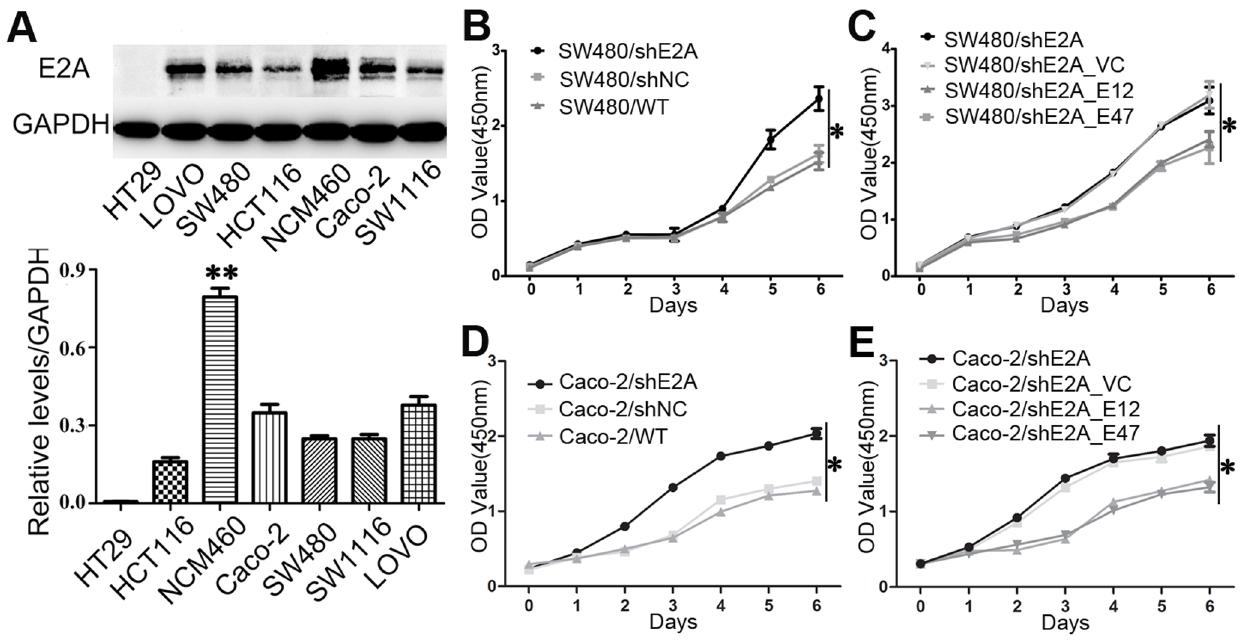
Figure 3. Knockdown of E2A promotes colon cancer cell growth. (A) Expression of E2A in normal human colon mucosal epithelium cell NCM460 and CRC cells lines was shown by western blot. GAPDH was used as loading control; (B) and (D) Cells with downregulated E2A expression (SW480/shE2A, Caco-2/shE2A) showed higher cell proliferation rate than that of the negative control (SW480/shNC, Caco-2/shNC) and wild type (SW480/WT, Caco-2/WT) cells; (C) and (E) Parental cells (SW480/shE2A, Caco-2/shE2A) were co-transfected with E12 or E47 plasmid (SW480/shE2A_E12 and SW480/shE2A_E47; Caco-2/shE2A_E12 and Caco-2/shE2A_E47) to restore E2A expression. Co-transfected cells showed decreased cell proliferation rate than that of the parental or vector control (SW480/shE2A_VC, Caco-2/shE2A_VC) transfected cells. All data represented as mean value 6 SD from 3 independent experiments. (*, P , 0.05).